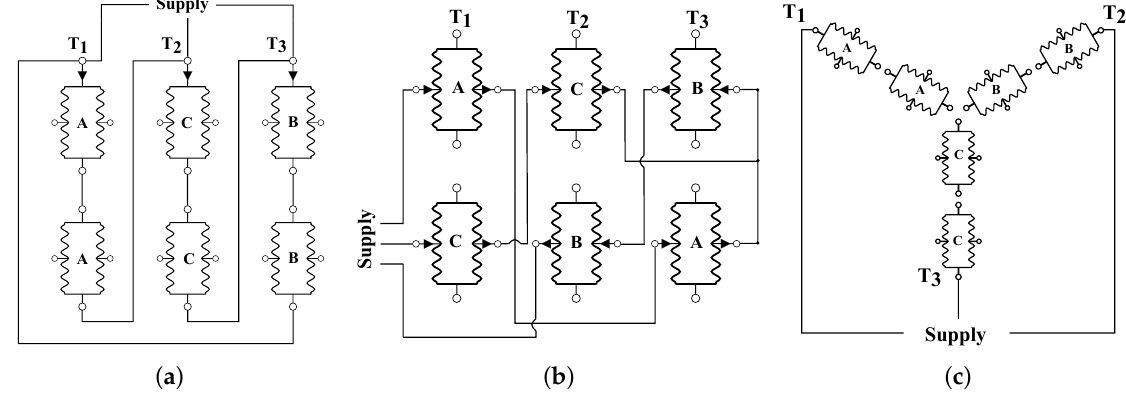
Figure 4. Hunt motor stator connections: ( a ) 4 poles, ( b ) 8 poles, and ( c ) (4 + 8) poles